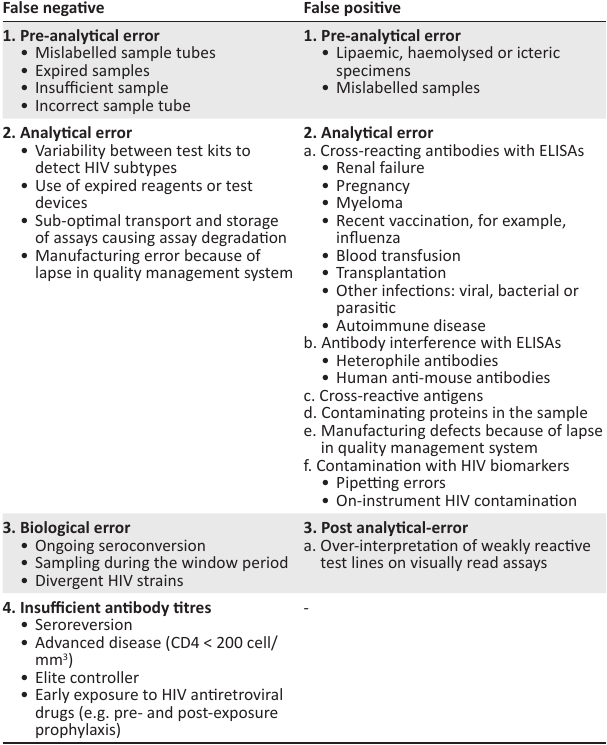
TABLE 1: Causes of false serology test